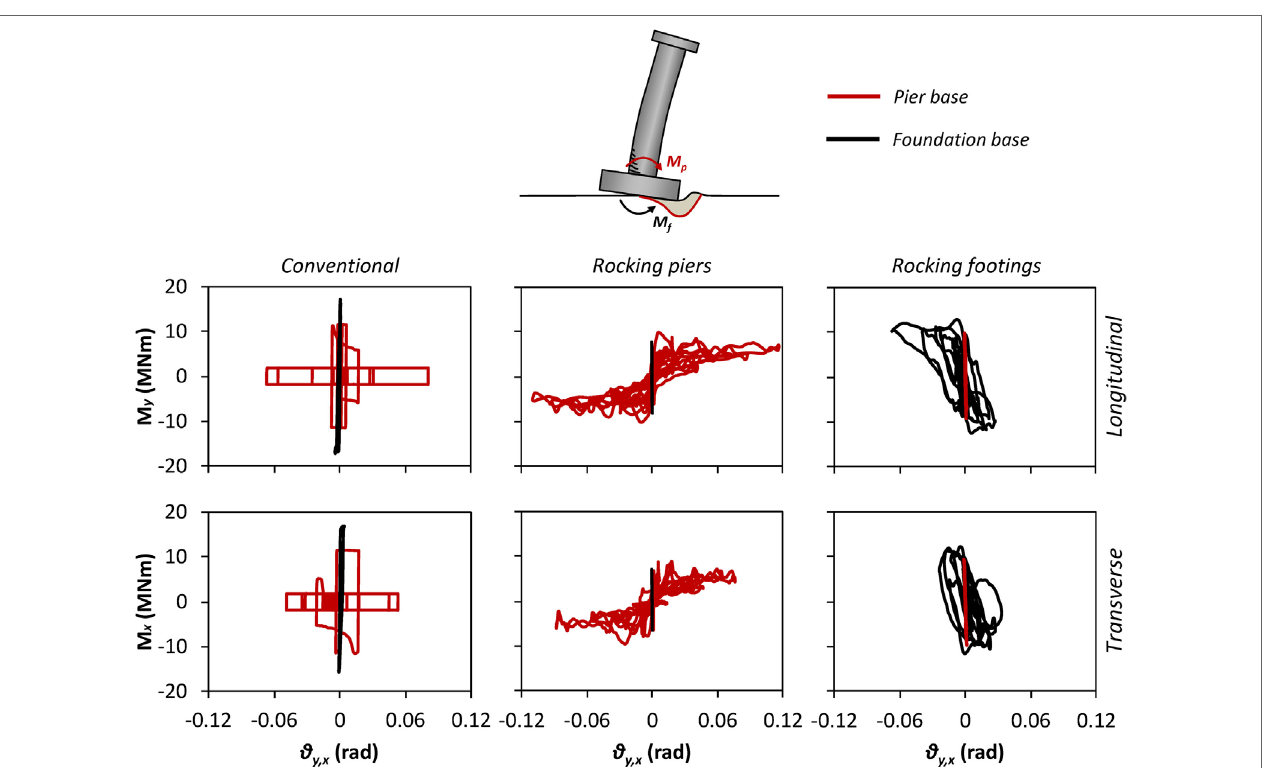
FigUre 12 | Comparison of the three design alternatives in terms of moment–rotation ( M – θ ) response at each direction indicatively for pier P4 of the bridge for the Takatori